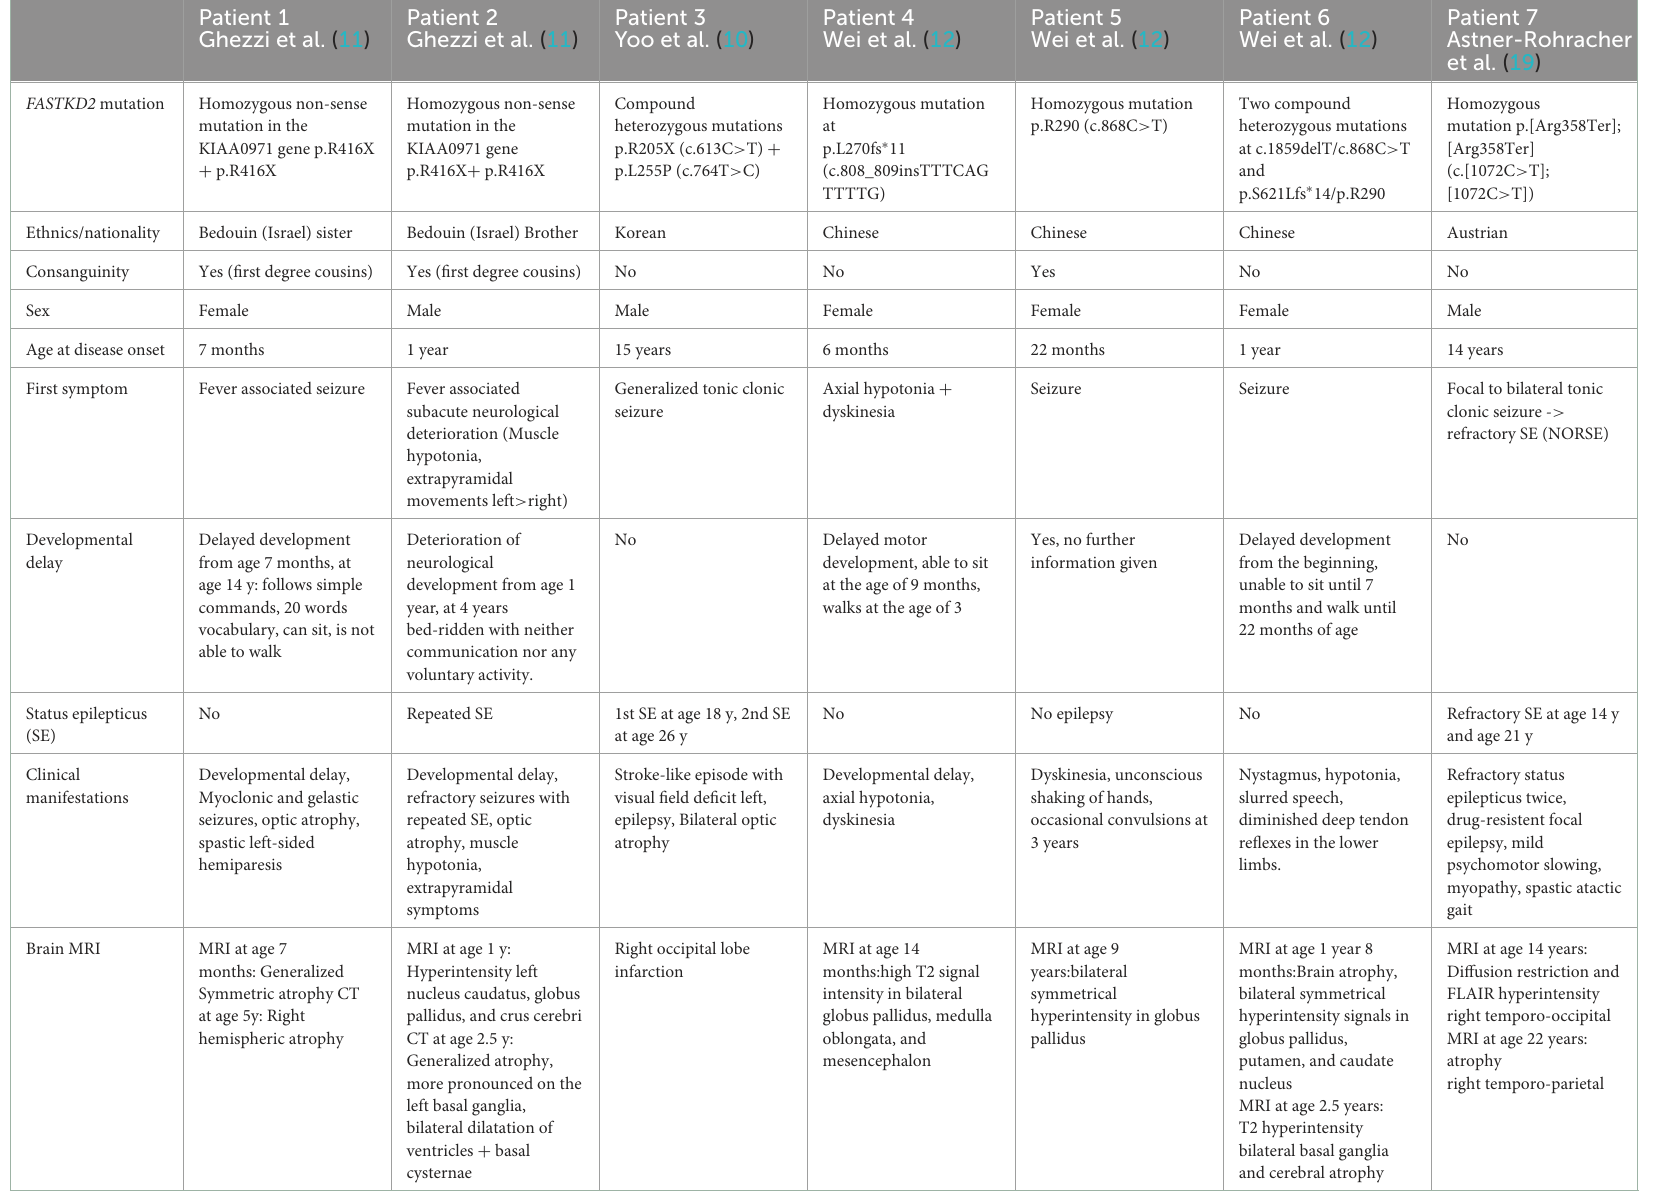
TABLE 1 Comparison of published cases with FASTKD2-related mitochondrial disease